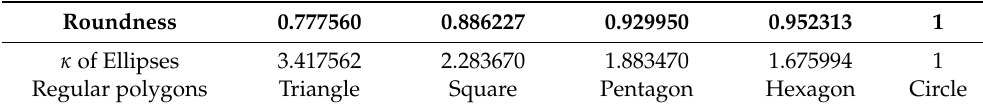
Table 6. The relationship between precision and elapsed time. Roundness Regular polygons Triangle Square Pentagon Hexagon